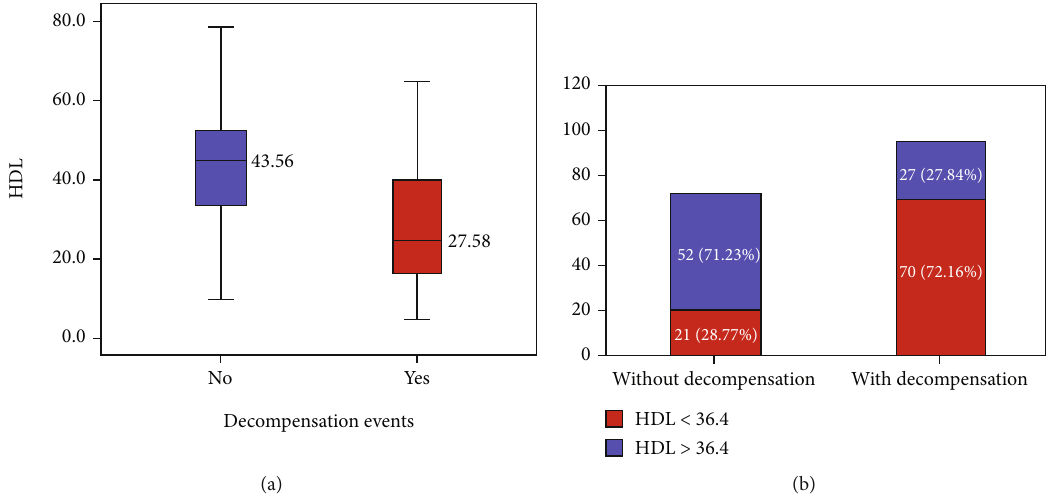
Figure 1: Association of HDL-C with decompensation events on follow-up in patients with CLD. (a) Comparison of mean HDL-C levels between patients with decompensation and those with stable decompensated disease. (b) Association of HDL − C < 36 : 4 mg/dL with risk of decompensation events on follow-up. ∗ Abbreviations: CLD: chronic liver disease; HDL-C: high-density lipoprotein